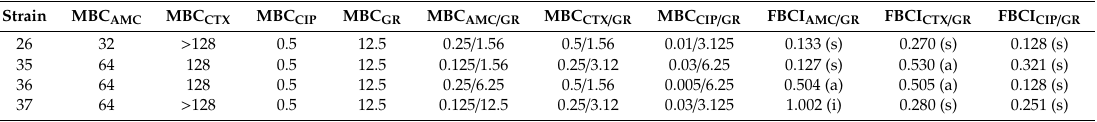
Table 4. Average MBC values of amoxicillin / clavulanic acid, cefotaxime, and ciprofloxacin alone and combined with GR-OLI, and relative FBCI